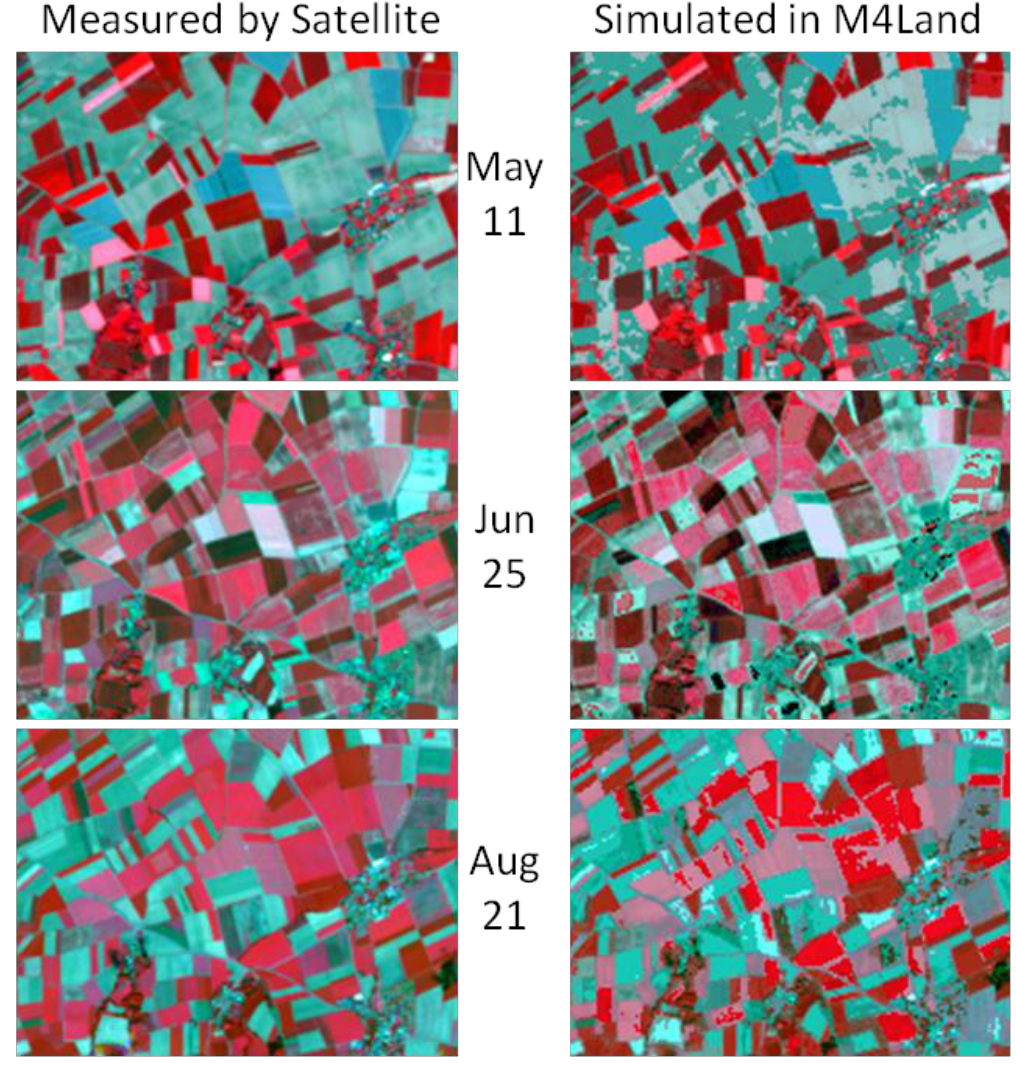
Figure 10. Real (left) compared with simulated (right) satellite images for selected dates during the growing